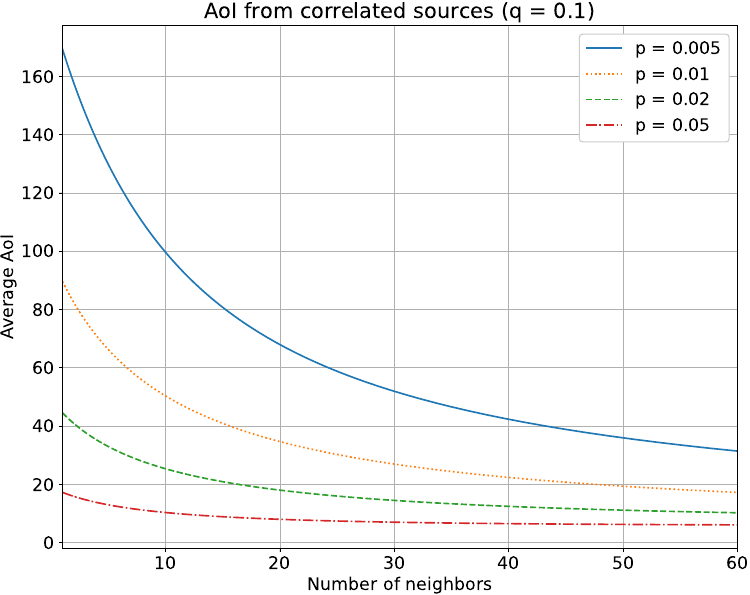
Figure 2. Behavior of the average AoI with a variable number of neighbors ( N ) in a strongly correlated scenario ( q = 0.1) with the concurrent access